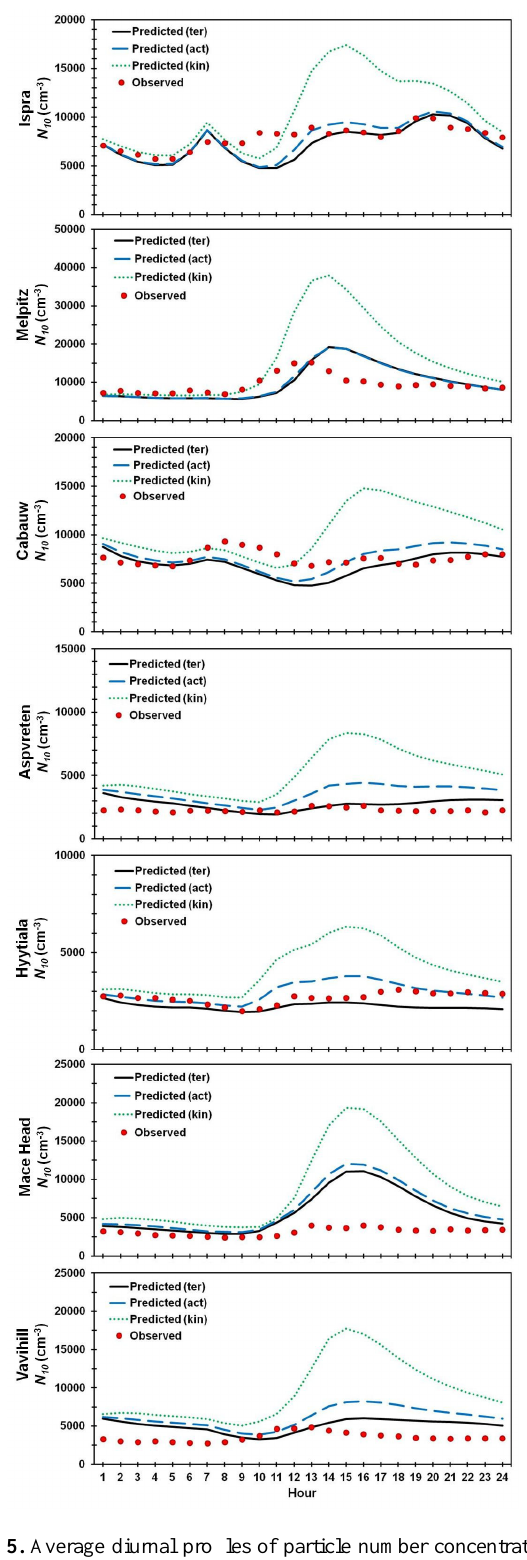
Figure 5. Average diurnal profiles of particle number concentrations (cm -3 ) above 10 Fig. 5. Average diurnal profiles of particle number concentrations (cm − 3 ) above 10nm in 7 measurement stations during May 2008. nm in 7 measurement stations during May 2008.